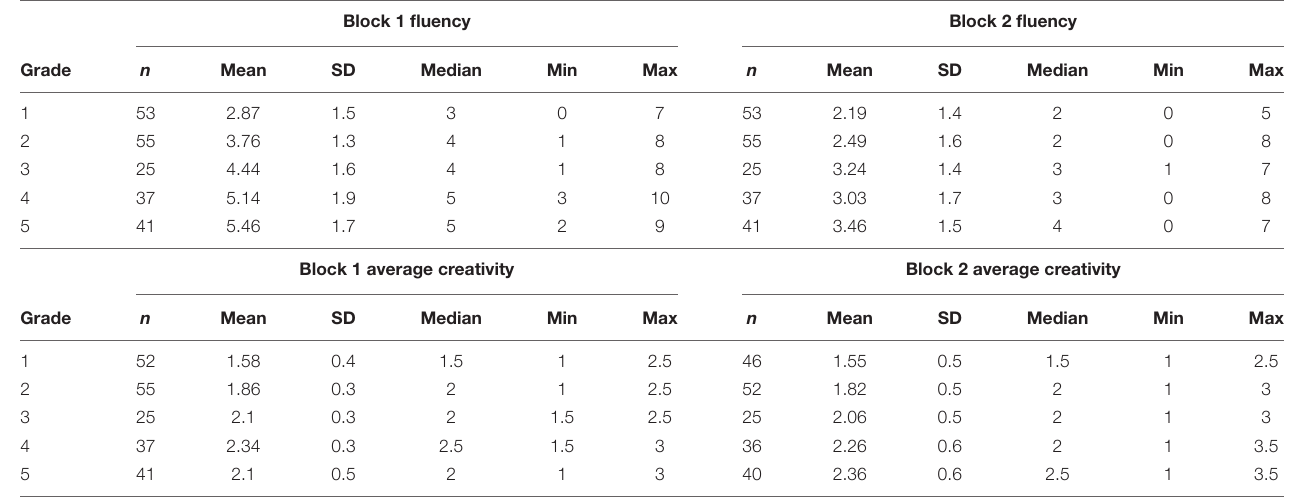
TABLE 1 | Descriptive statistics of fluency and creativity across grade.